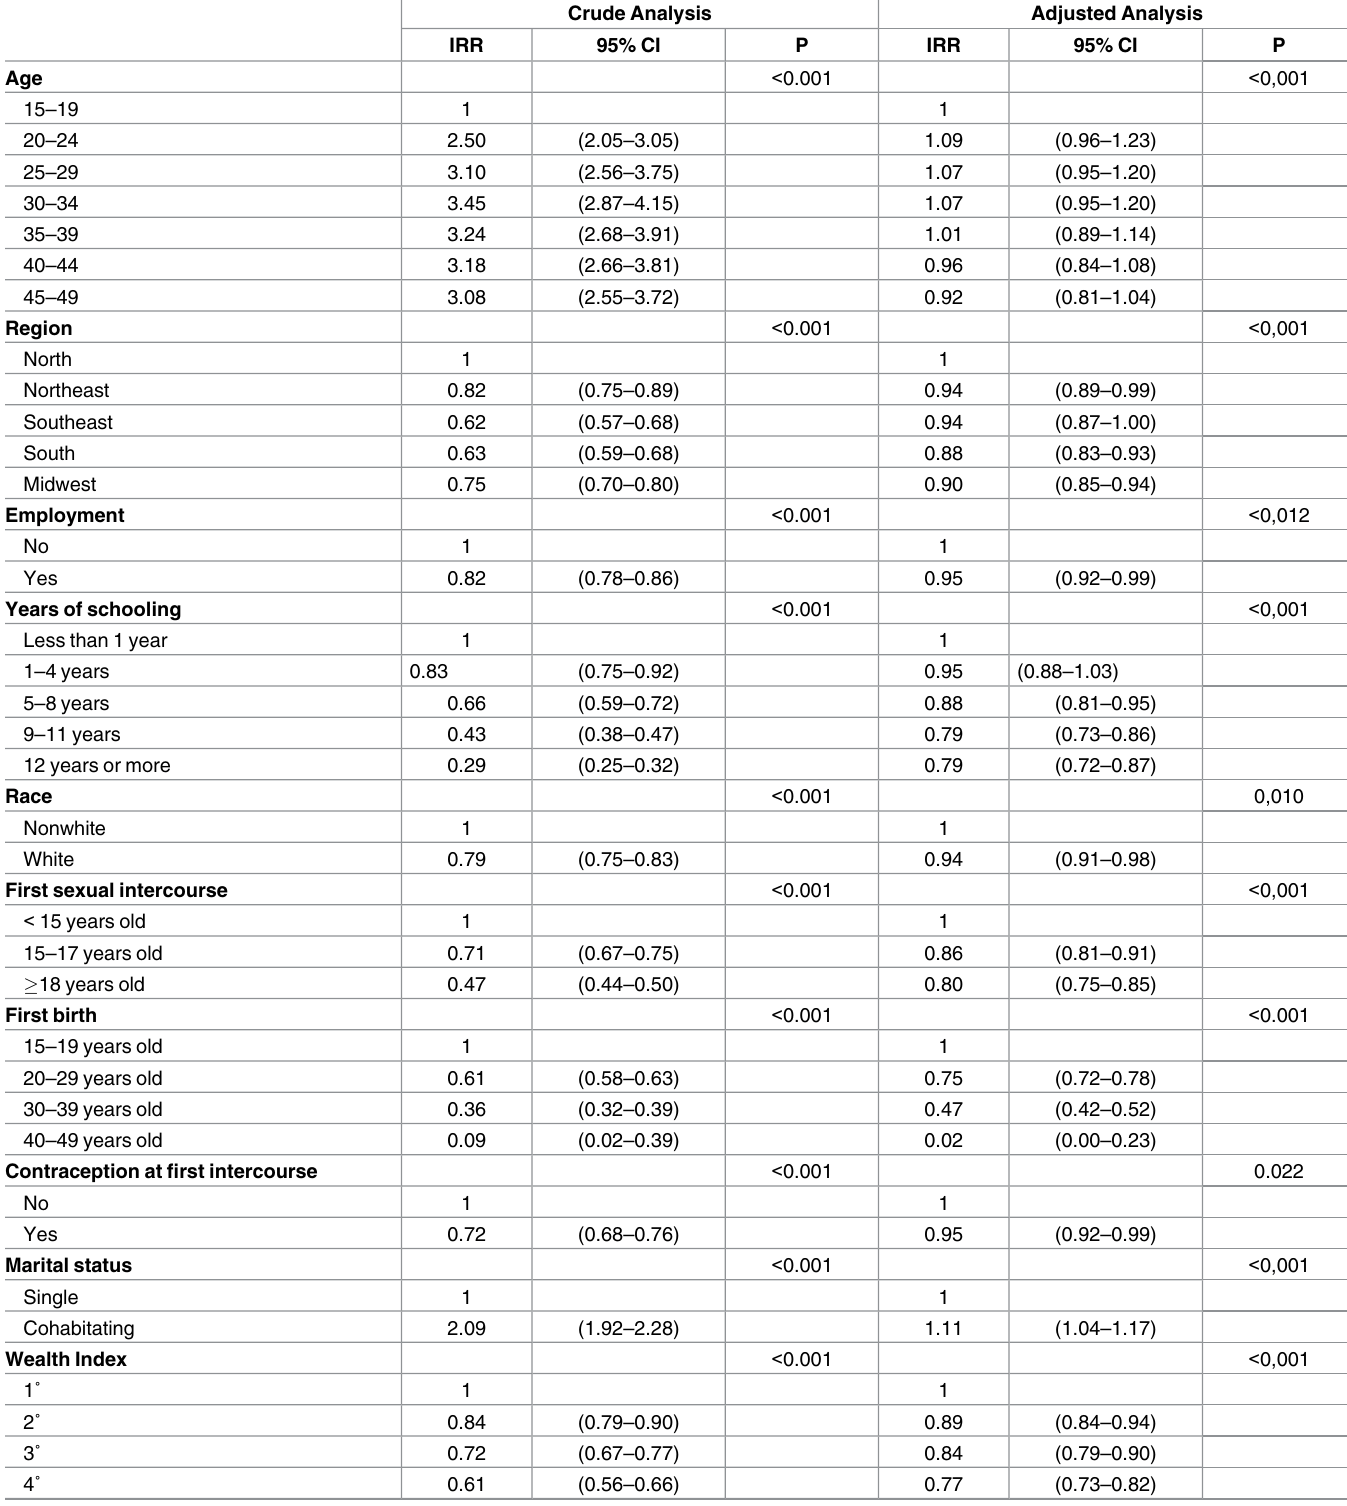
Table 2. Crude and adjusted incidence rate ratios (IRRs) estimated using Poisson